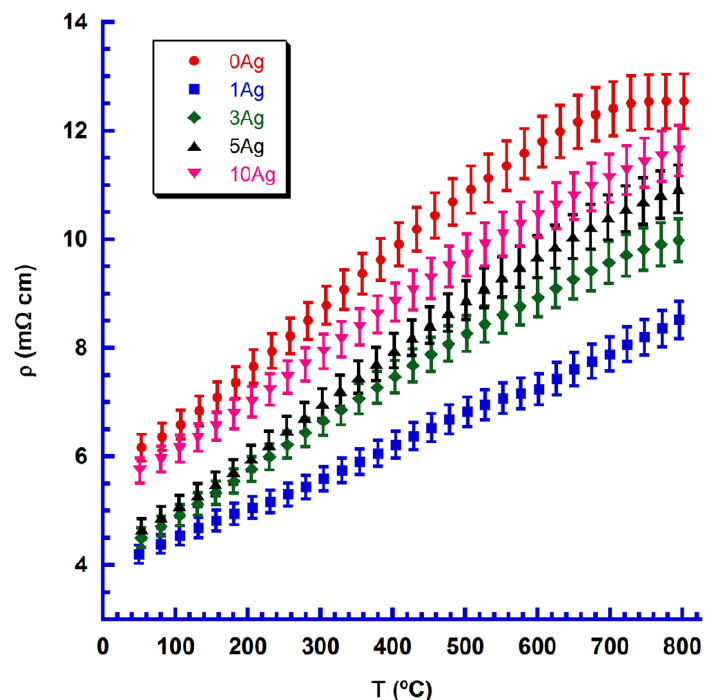
Figure 4. Electrical resistivity change with temperature for Ca 0.9 Yb 0.1 MnO 3 + x wt.% Ag samples (given as a function of Ag content), together with their measurement errors.